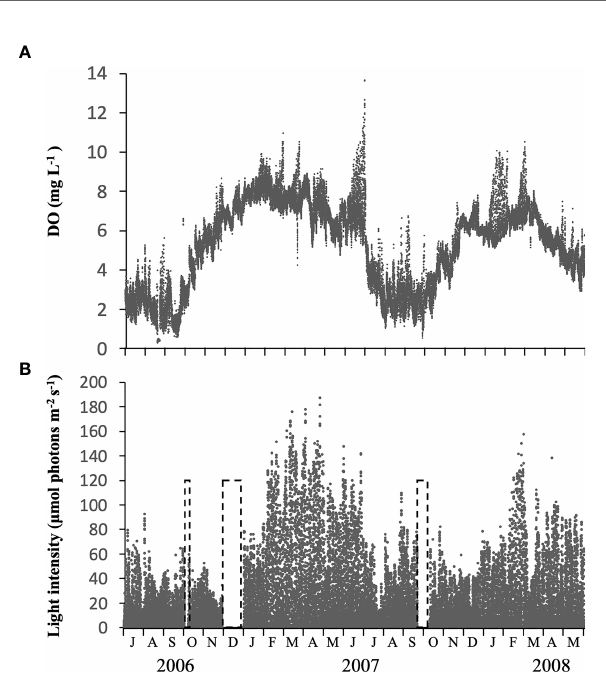
FIGURE 5 | Temporal changes in concentration of dissolved oxygen (DO) (A) and light intensity (B) measured at 0.3 m above the bottom, using memory meters, at the sampling site in Ago Bay. The periods in the dashed frame indicate that no data was recorded.